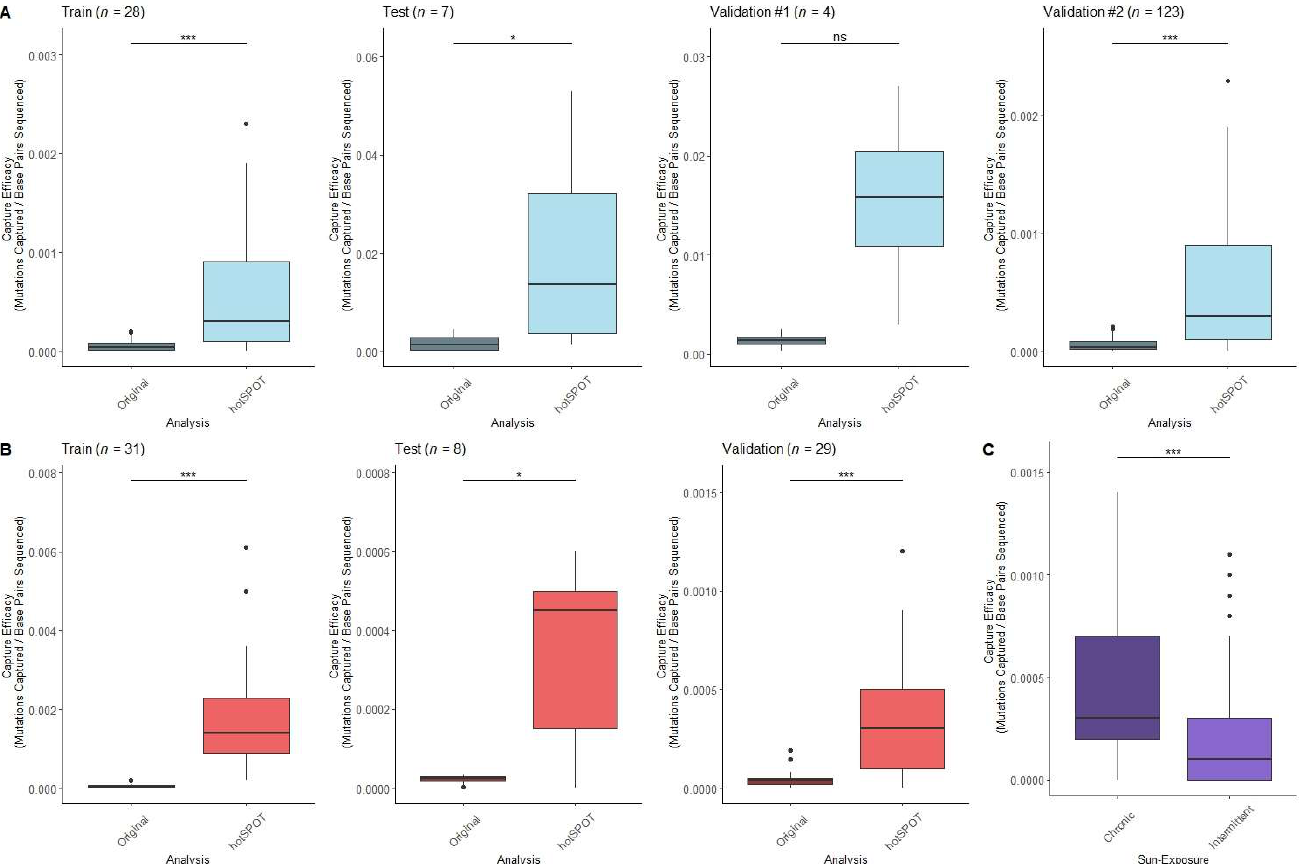
Figure 3. The mutation capture efficiency of hotSPOT for targeted sequencing panel design. ( A ) Difference in capture efficacy from original sequencing analysis compared to 10,000 bp sequencing panel based on training normal epidermis dataset. ( B ) Difference in capture efficacy from original sequencing analysis compared to 10,000 bp sequencing panel based on training cSCC dataset. ( C ) Difference in capture efficacy from chronically sun-exposed and intermittently sun-exposed normal epidermal samples based on 10,000 bp cSCC hotSPOT panel. Statistical significance was calculated using paired Wilcox signed-rank test. Sequencing panels based on forward hotSPOT binning algorithm. ( p ≥ 0.05 ns, p < 0.05 *, p < 0.01 **, p < 0.001 ***).